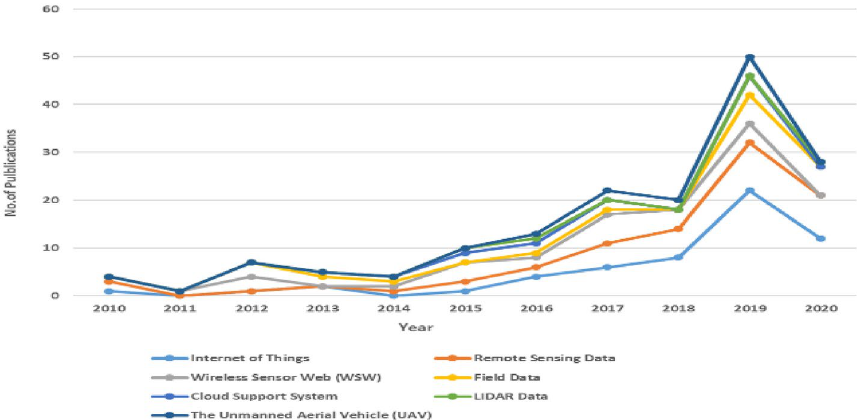
Fig. 12 The number of published studies utilizing technologies in precision agriculture per